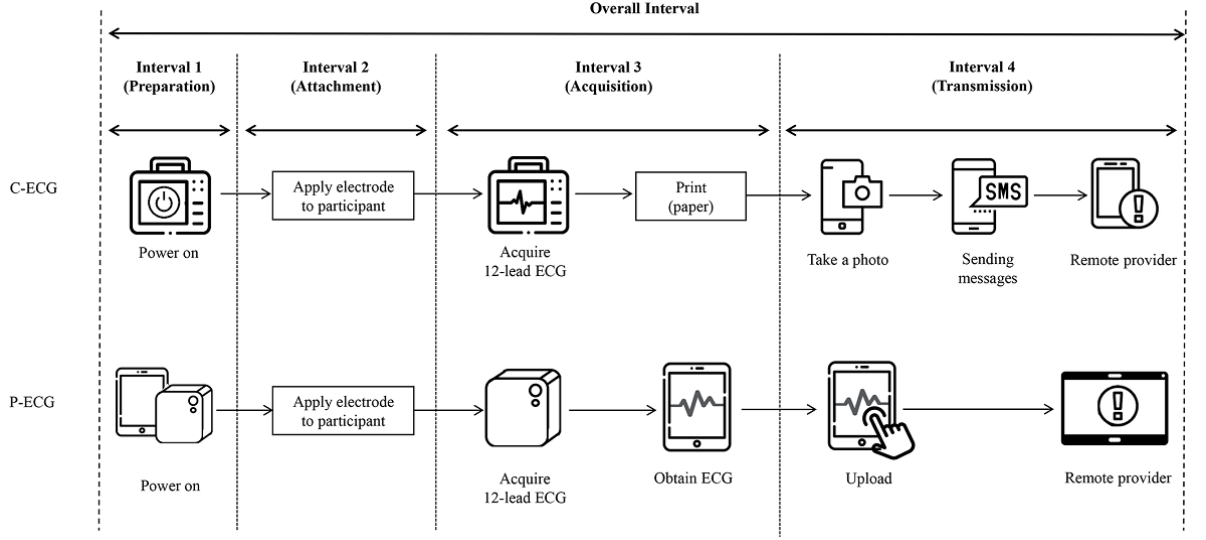
Figure 3. Definition of outcomes (intervals). The overall interval was defined as the interval from the "start" command to the acquisition of